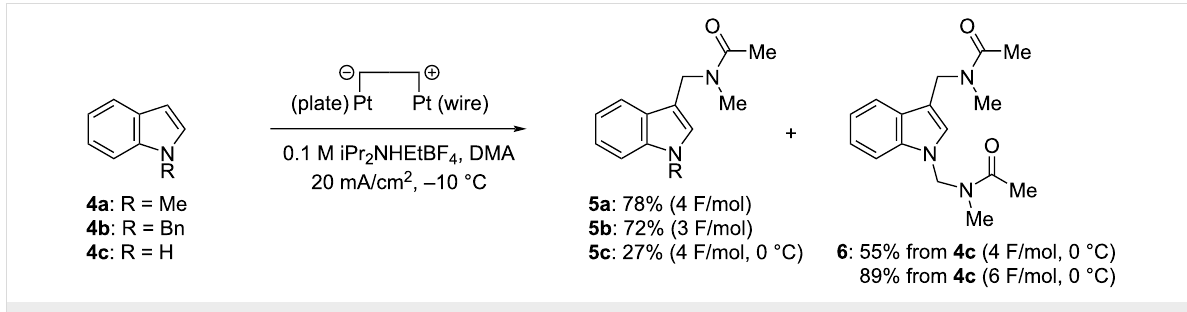
Scheme 2: Electrochemical amidomethylation of indoles 4 in DMA.